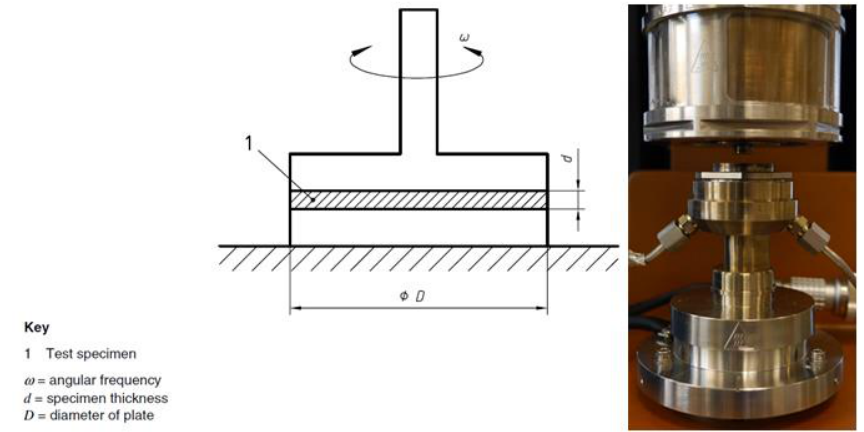
Fig. 1 Measurement in plate/plate geometry: schematically (left) and actual equipment (right).